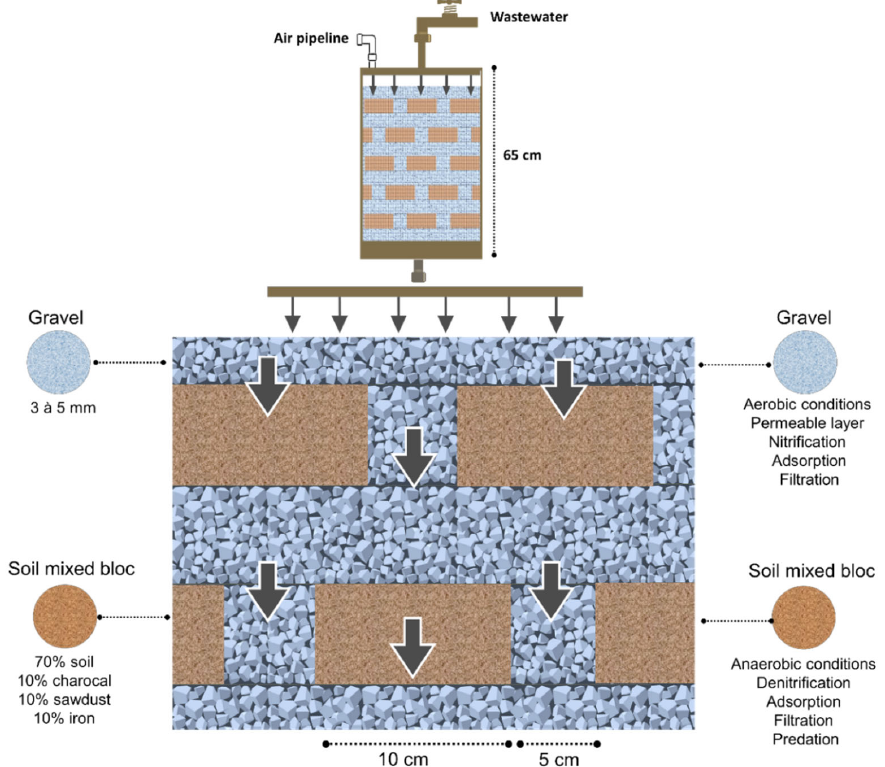
Figure 4. Illustration of an experimental model of a multi-soil-layering system with the major removal mechanisms.